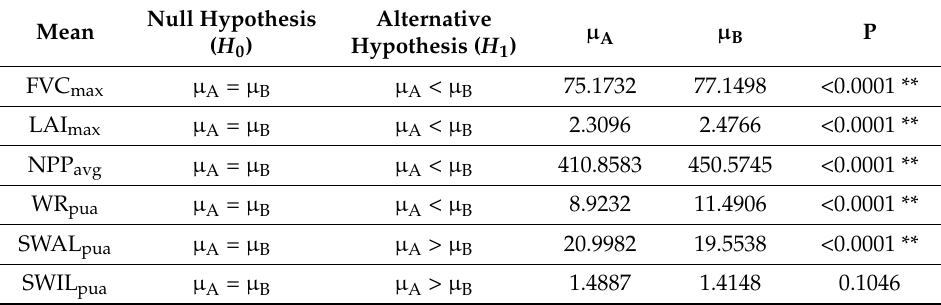
Table 8. Null hypothesis and alternative hypothesis of mean annual values of ecosystem quality and ecosystem services indicators between Sample A and Sample B from 2000–2010. µ A and µ B are, respectively, the mean of annual values of indicators of Sample A and Sample B, and the units from